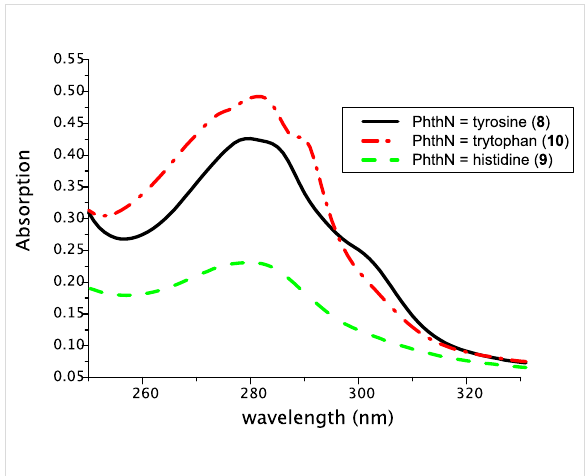
Figure 3: UV–vis absorption spectra of compounds 8 – 10 ( c = 2 × 10 − 4 in